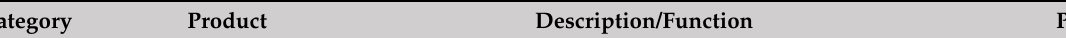
Table 1. A list of kenaf-based products.